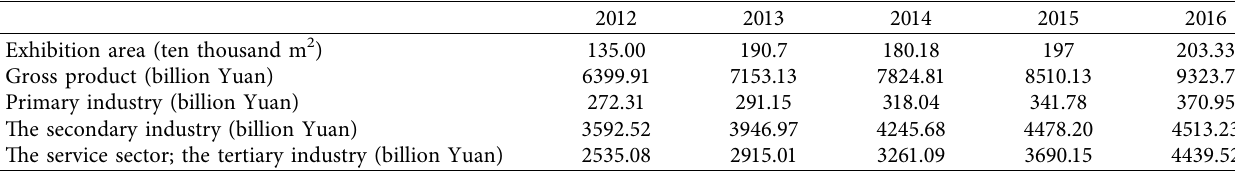
Table 2: Changsha exhibition and output statistics in 2012 ∼ 2016.